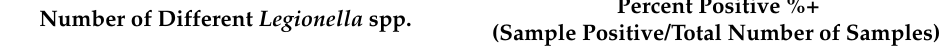
Table 2. Number of samples with no-detects, single and multiple Legionella species. Number of Different Legionella